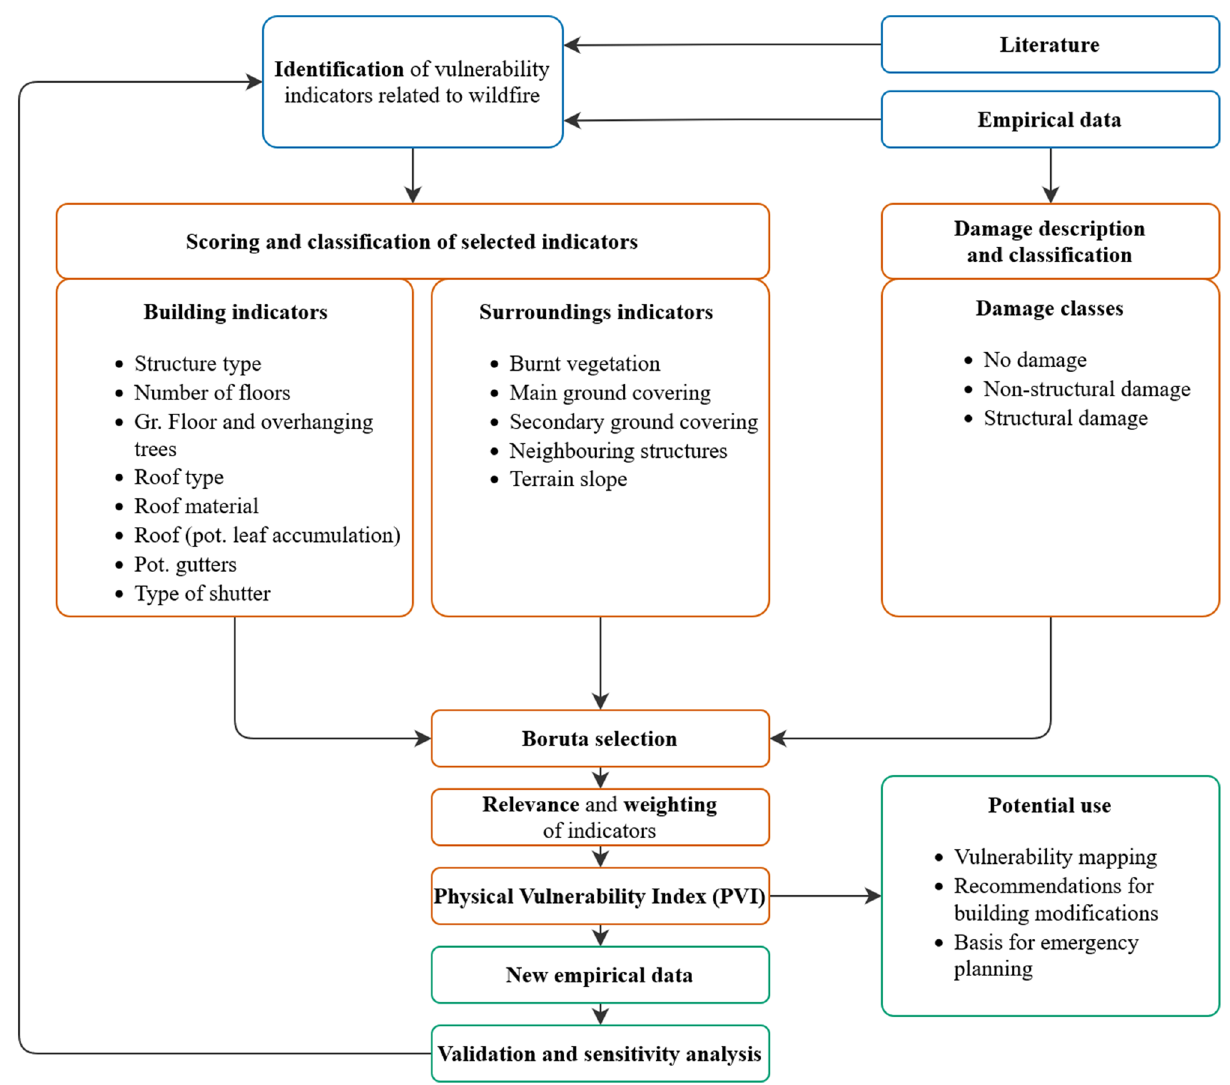
Figure 1. The methodological flow of the study (showing also—in green—possible future steps that are not included in the present